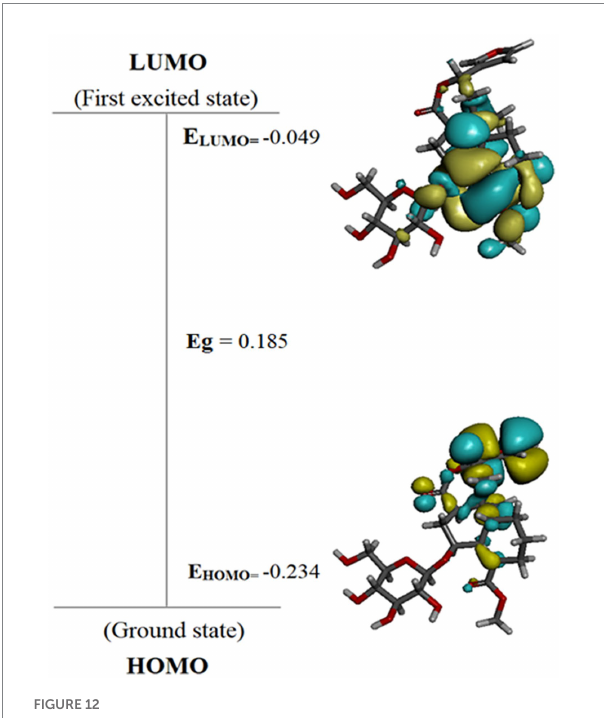
FIGURE 12 HOMO–LUMO energy diagram of most reactive compound- Cordifoliside C.